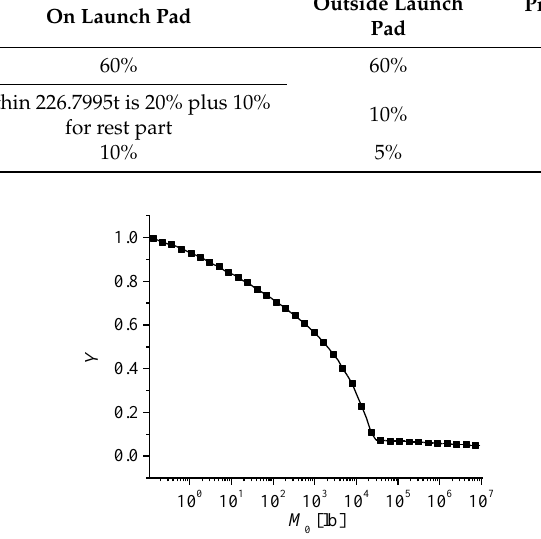
Table 2. Explosive yields and specific coefficients of different liquid propellant combinations under different explosion modes.